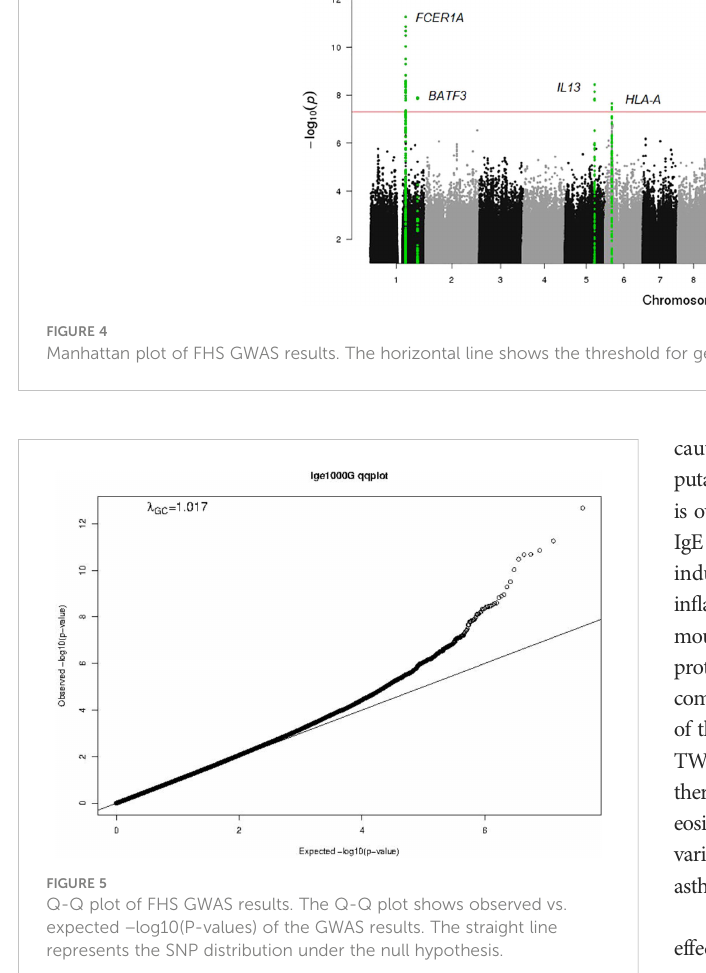
TABLE 5 Bi-directional MR results for genes putatively causal for IgE levels at p<0.05 (n=4).